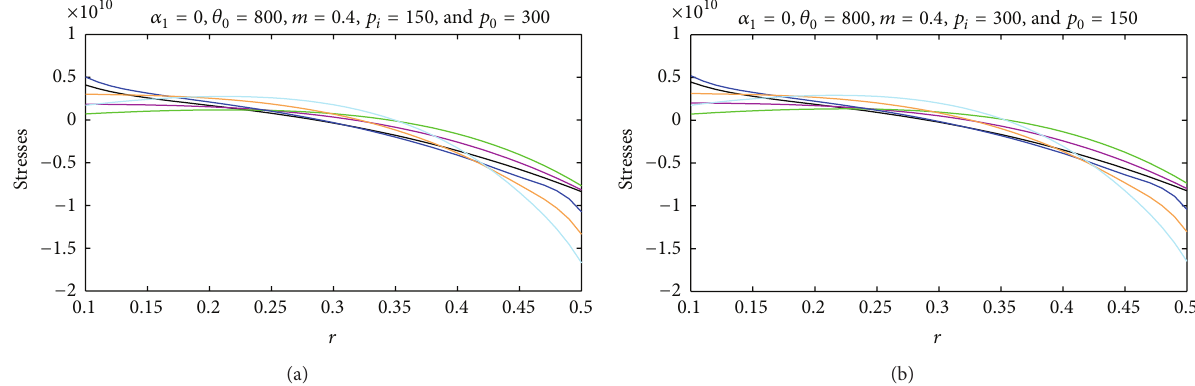
Figure 7: Elastic-plastic stresses in a rotating cylinder with variable thickness and variable density with thermal effects ( 𝜃 0 = 800 ) with parameters 𝑒 1 = 0, 1, 2 and strain hardening measure 𝑚 = 0.4 under internal and external